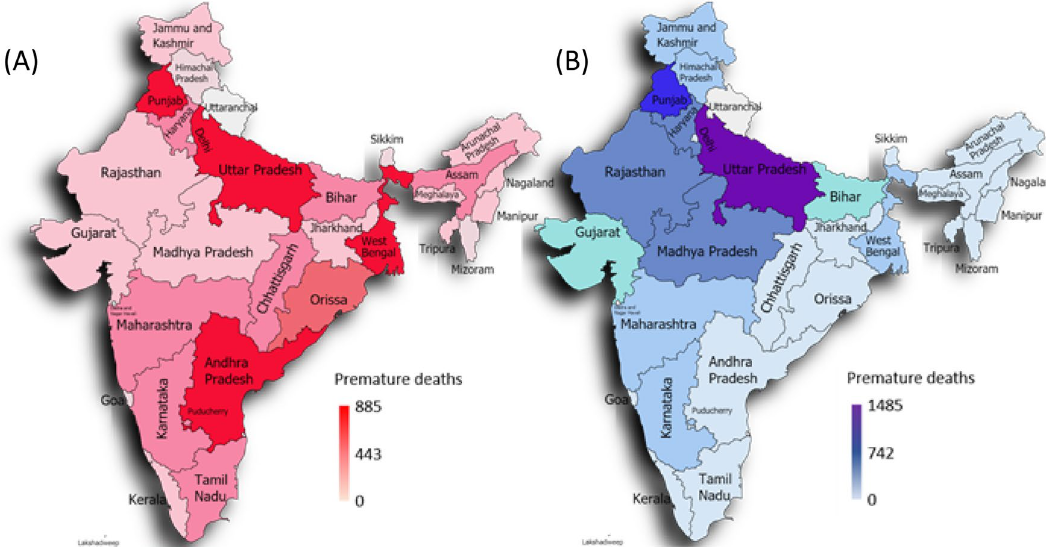
Figure 5. Spatial distributions of the PM 2.5 emission-related premature deaths via rice ( A ) and wheat ( B ) supply chains. Maps generated in Paintmaps.com (https:// paint maps.